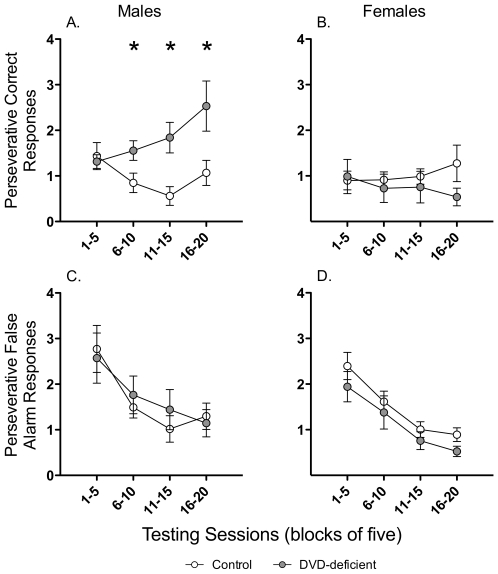
Perseverative responding in the 5C-CPT.This figure shows the perseverative correct responses (A and B) and the perseverative false alarm responses (C and D) for control (n = 9–10) and DVD-deficient (n = 9–10) males (left) and females (right) averaged over 4 blocks of 5 trials. DVD-deficient males made more perseverative responses during target trials, particularly in the later sessions (Sessions 6–10 t
1,17 = −2.32, P = 0.033; Sessions 11–15 t
1,17 = −3.16, P = 0.006; Sessions 16–20 t
1,17 = −2.31, P = 0.034). Data are expressed as mean ± SEM. * P<0.05 and τ P<0.1 between control and DVD-deficient mice.